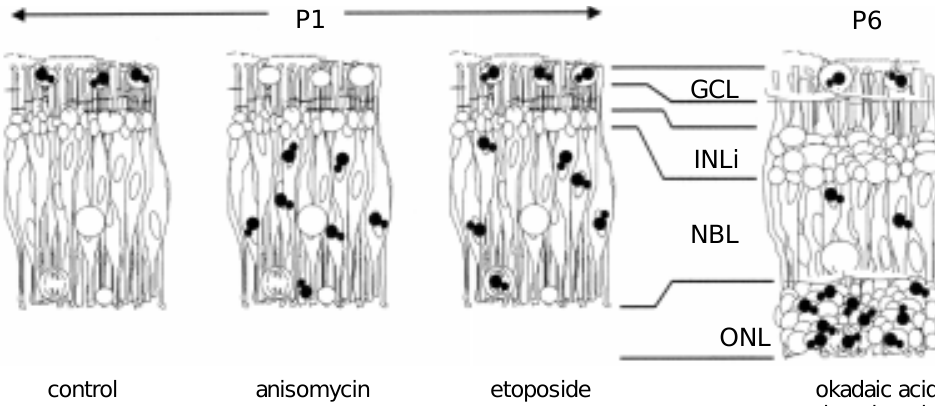
Figure 2 - Location of apoptotic bodies (filled twin circles) in reti- nal explants either at birth (P1) or at P6, following 24 h of treat- ment as indicated below each drawing. Apoptosis within the neuroblastic layer (NBL) follow- ing treatment with anisomycin occurs predominantly in recent postmitotic cells, while etopo- side kills proliferating cells in the NBL of retinal explants from newborn rats. Abbreviations for retinal layers are as in Figure